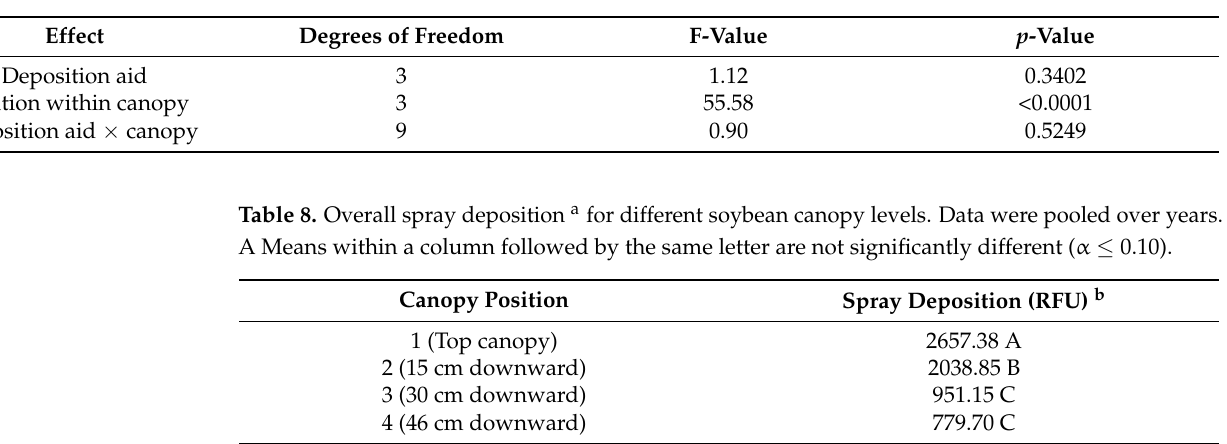
Table 7. Analysis of variance and associated p -values for deposition aids and canopy levels influencing spray deposition on soybean. Data were pooled over years.